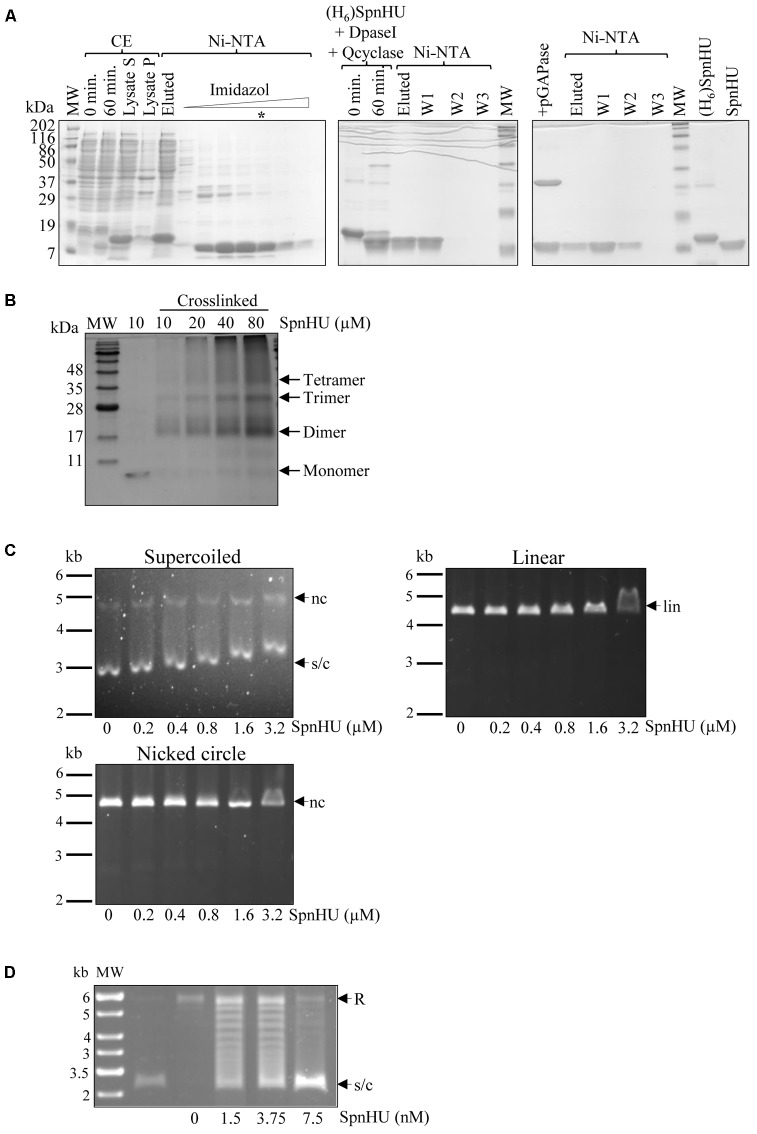
In vitro characterization of SpnHU activity. (A) Purification of recombinant [(H6)SpnHU] and native (SpnHU) proteins. A culture of E. coli XL1blue (pQEHU) was grown and induced with IPTG as described in Section “Materials and Methods.” Samples were electrophoresed in SDS-12% polyacrylamide gels and polypeptides stained with Coomassie Blue. Left image: expression of (H6)SpnHU and purification steps. CE, crude extract (20 μg per lane); 0 and 60 min, samples after IPTG induction; lysate S and lysate P, supernatant and pellet after lysis and centrifugation. Fractions (15 μl) of a Ni-NTA column in which an imidazole gradient was applied. The lane marked with an asterisk contains the (H6)SpnHU that was used for further purification. Middle image: DpaseI and Qcyclase treatment followed by Ni-NTA purification. Right image: pGAPase treatment followed by Ni-NTA purification and 3 μg of purified proteins (H6)SpnHU and SpnHU. MW, molecular weight markers. (B) Oligomerization status of SpnHU. The indicated amounts of crosslinked native protein were separated by SDS-PAGE, and the gels were stained with Coomassie. (C) Agarose gel-based EMSAs showing the binding of increasing concentrations of SpnHU to 0.03 pmol supercoiled (s/c), linear (lin) or nicked (nc) plasmid pBR322. (D) Agarose gel electrophoresis showing the supercoiling s/c of relaxed (R) pBR322 plasmid after incubation with pneumococcal topoisomerase I in the presence of the indicated amounts of SpnHU (second and consecutive lanes). The first lane shows the DNA molecular weight marker with sizes indicated in kb, and the second lane shows supercoiled pBR322 before relaxation with topoisomerase I.